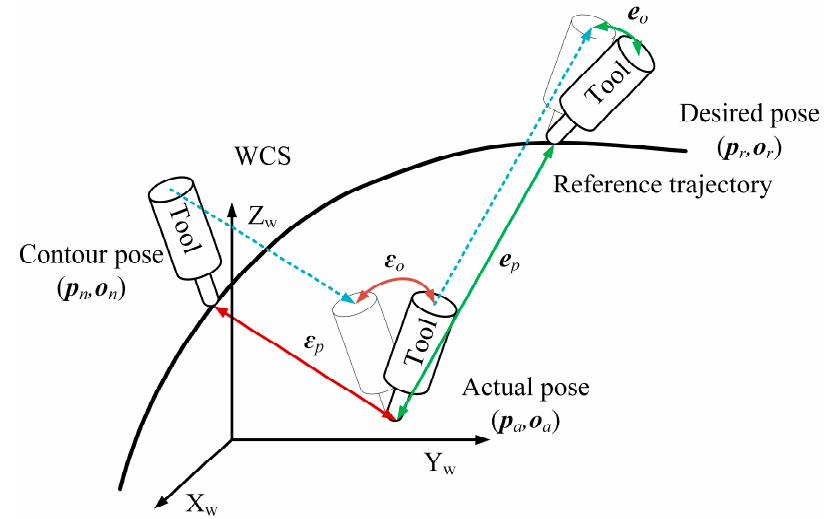
Figure 2. Five-axis tracking error and contour error.